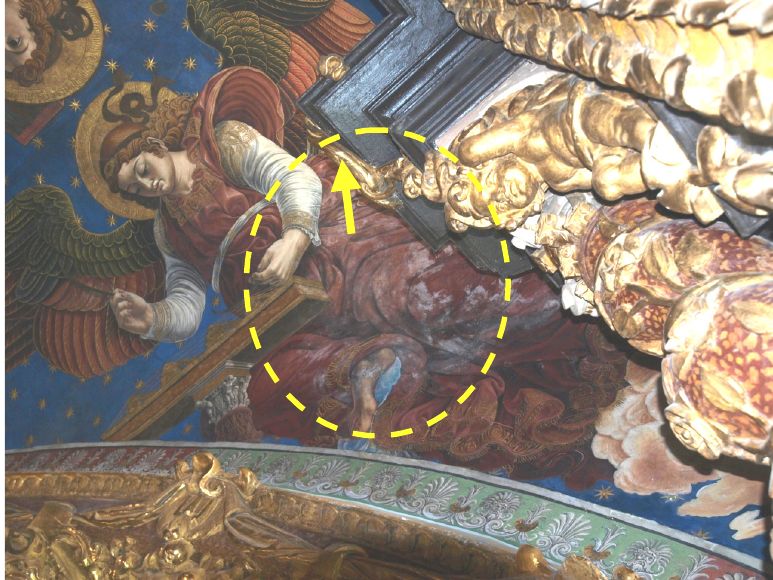
Figure 7. Picture of the fresco painting where sensor AB is located (exact position indicated with an arrow). The dashed ellipse highlights a zone with white salt efflorescence stain. The picture was taken in March